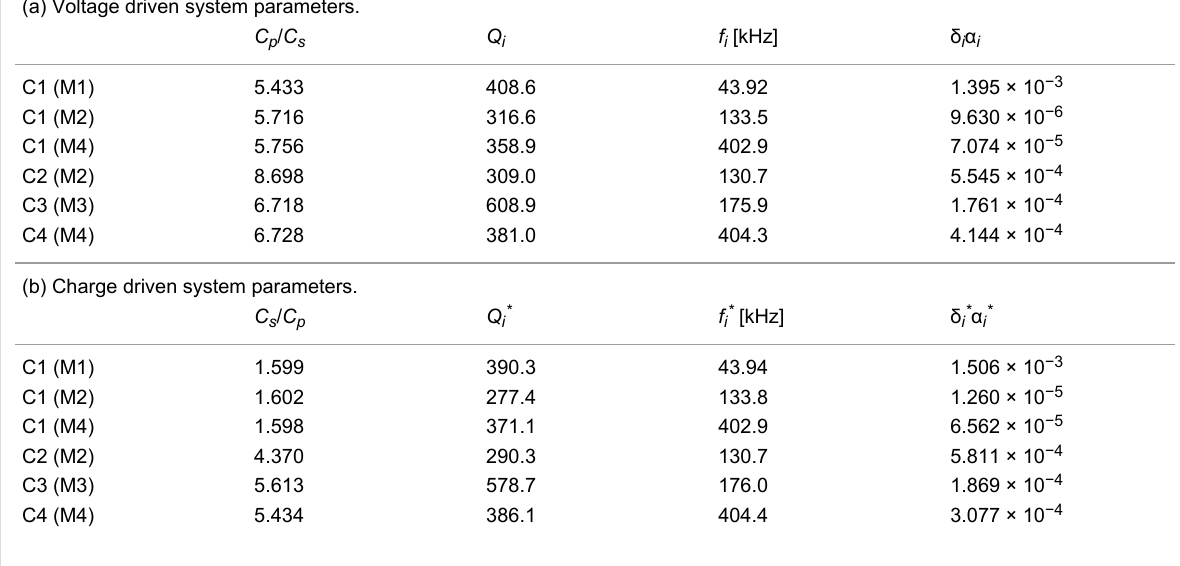
Table 3: Parameters of the identified transfer functions around the